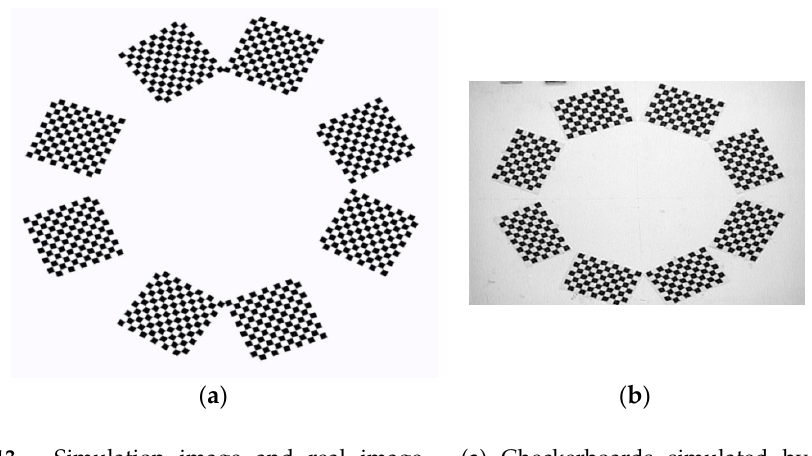
Figure 13. Simulation image and real image. ( a ) Checkerboards simulated by software; ( b ) Checkerboards captured by the auxiliary camera.